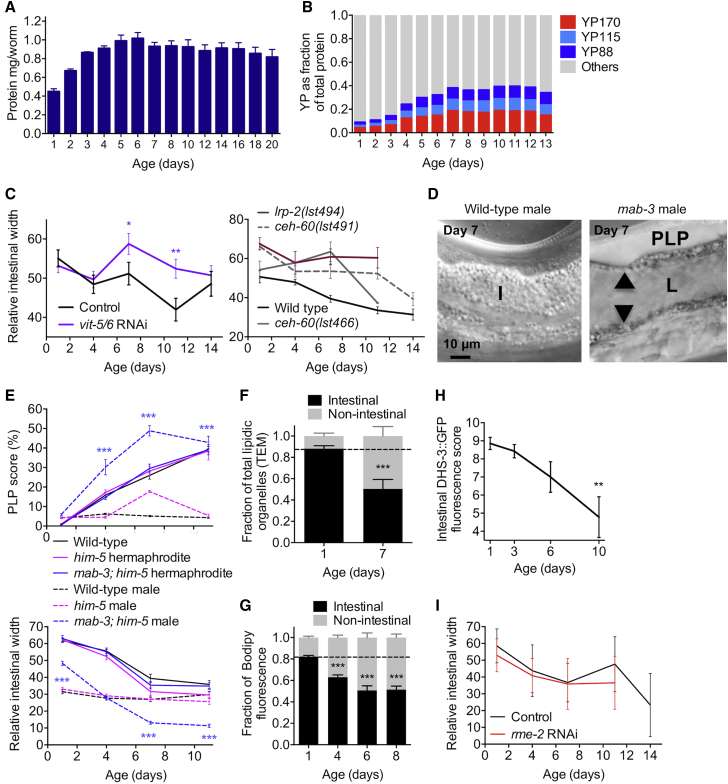
Evidence of Conversion of Intestinal Biomass into Yolk(A) Total protein content of wild-type worms across the course of a lifetime, peaking at day 6.(B) The proportion of YP to total proteins increases 4-fold between day 1 and 7 (gel densitometric analysis).(C) Inhibition of yolk synthesis by vit-5/6 RNAi (left) or lrp-2 or ceh-60 mutations (right) rescues intestinal atrophy; N = 2 trials. All mutants are significantly different from wild-type (p < 0.05) at 2 or more time points.(D) Wild-type males show no gut atrophy (left), whereas yolk-producing mab-3(mu15) males exhibit PLPs and gut atrophy (right).(E) Quantitation of PLP accumulation (top) and gut atrophy (bottom) in mab-3 males; N = 2 trials. Asterisks indicate statistical comparison between mab-3; him-5 males and him-5 or wild-type males.(F) TEM of mid-body sections reveals a redistribution of intestinal lipids to other tissues between day 1 and 7.(G) Lipid redistribution confirmed by analysis of neutral lipid staining by Bodipy.(H) Numbers of DHS-3::GFP-marked lipid droplets decrease with age.(I) Inhibition of yolk uptake by rme-2 RNAi, which aggravates PLP accumulation, does not affect intestinal atrophy.Trials were conducted at 20°C, no FUDR (A–E) or 25°C with FUDR (F–I). ∗p < 0.05, ∗∗p < 0.01, ∗∗∗p < 0.001. See also Figure S4.